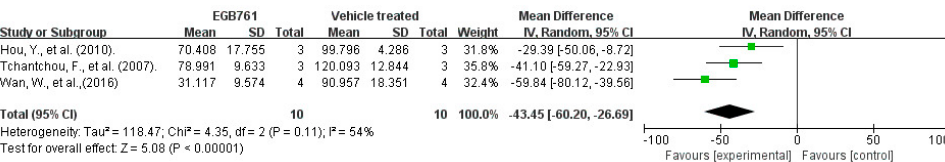
Figure 10. Forest plot for comparison: GBE treatment versus vehicle treatment. Outcome: A β density in the brain. The square area represents the weight assigned to the study in the meta-analysis. The horizontal line represents the 95% confidence interval.